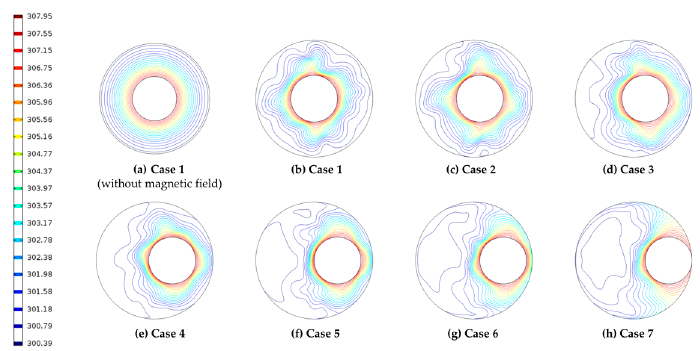
Figure 5. Nusselt number at each case.